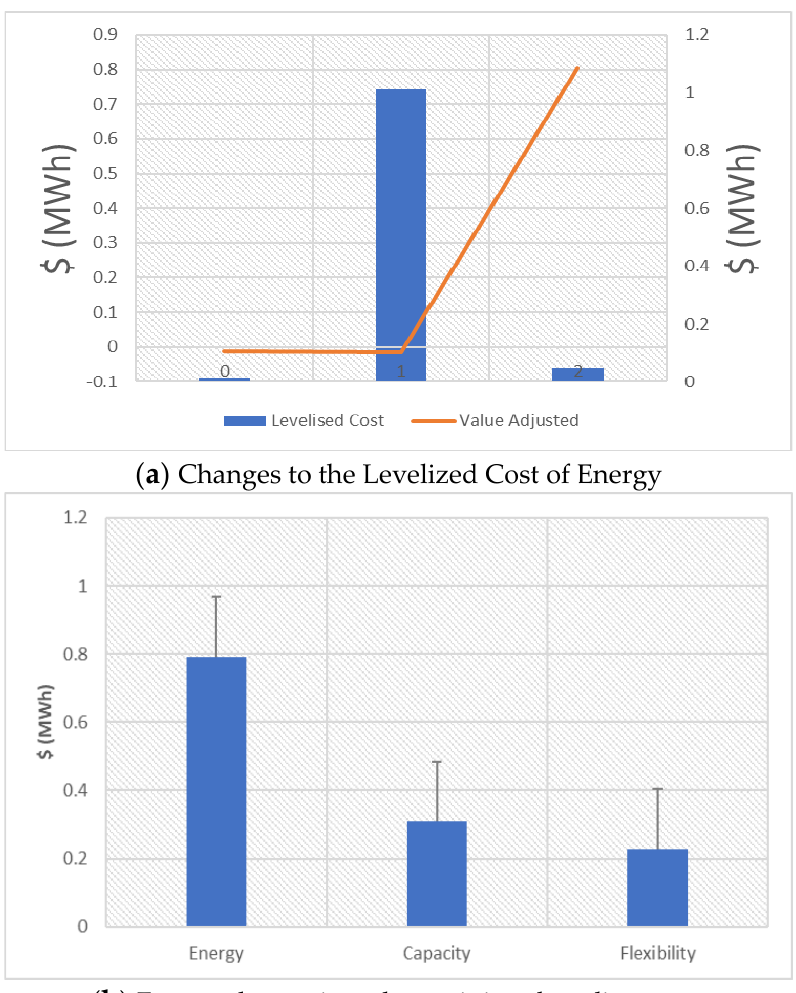
Figure 2. Using the VALCOE instead of the LCOE.